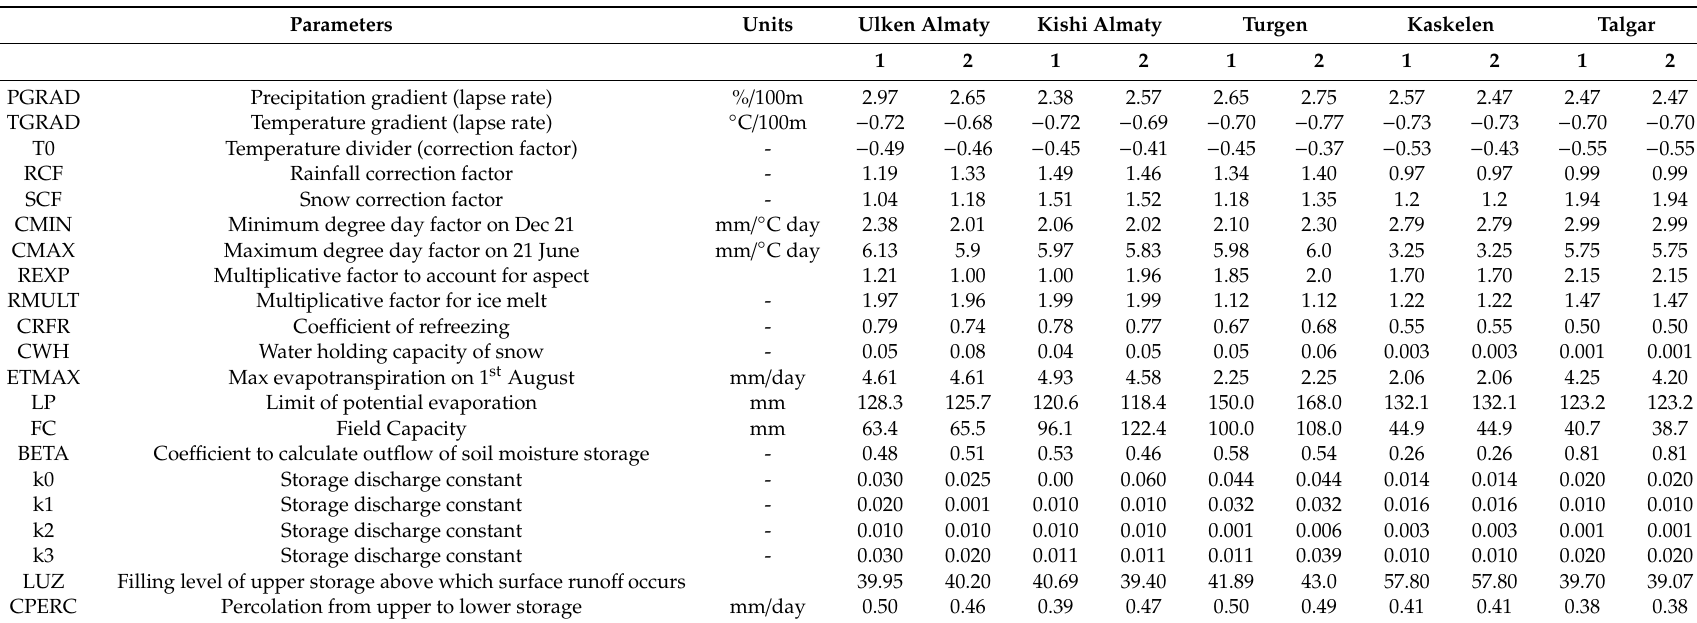
Table 5. Model parameters used during model calibration (C) and validation (V) for 2001–2005 period. See Mayr et al. (2013) for further details. The 1985–1995 and 2001–2005 (2007–2010 for the Talgar) periods are denoted as ‘1’ and 2’